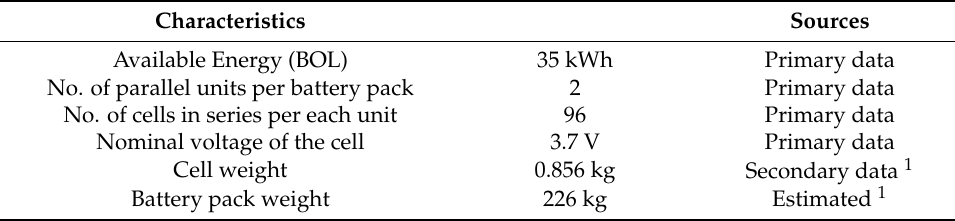
Table 1. Characteristics of the NMC111 battery pack.